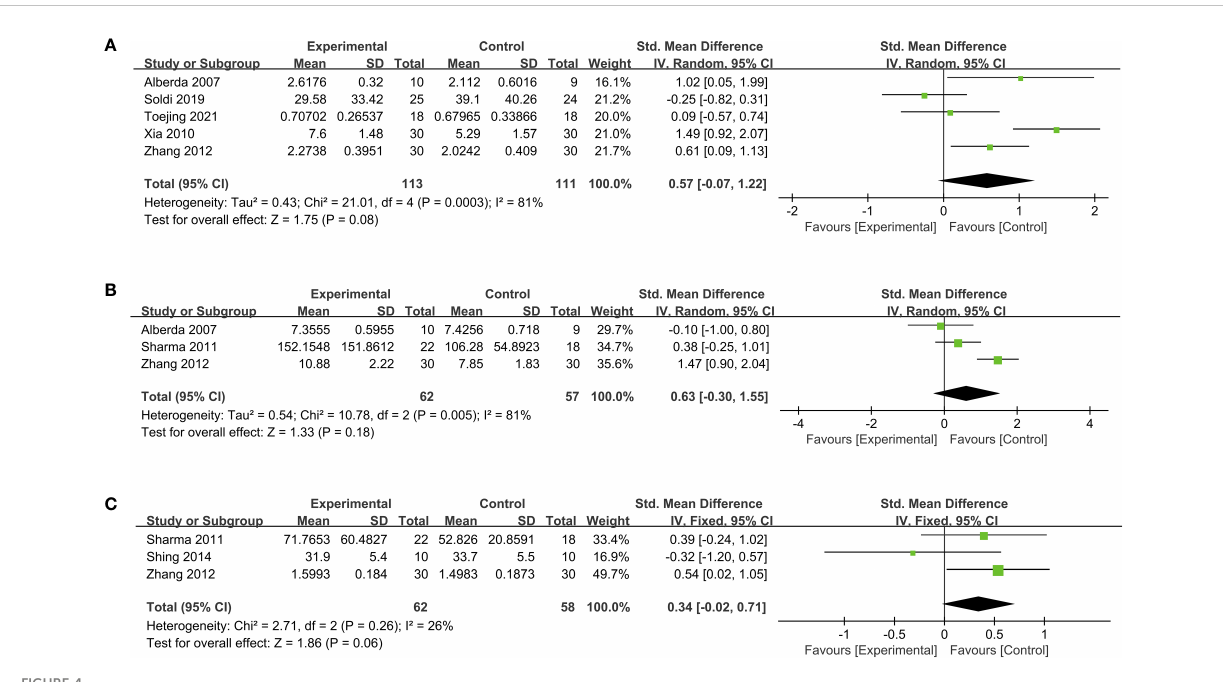
FIGURE 4 Forest plots of the effect of probiotics on immunoglobulin levels. (A) IgA, (B) IgG, (C) IgM. IgA, Immunoglobulin A; IgG, Immunoglobulin G, IgM, Immunoglobulin